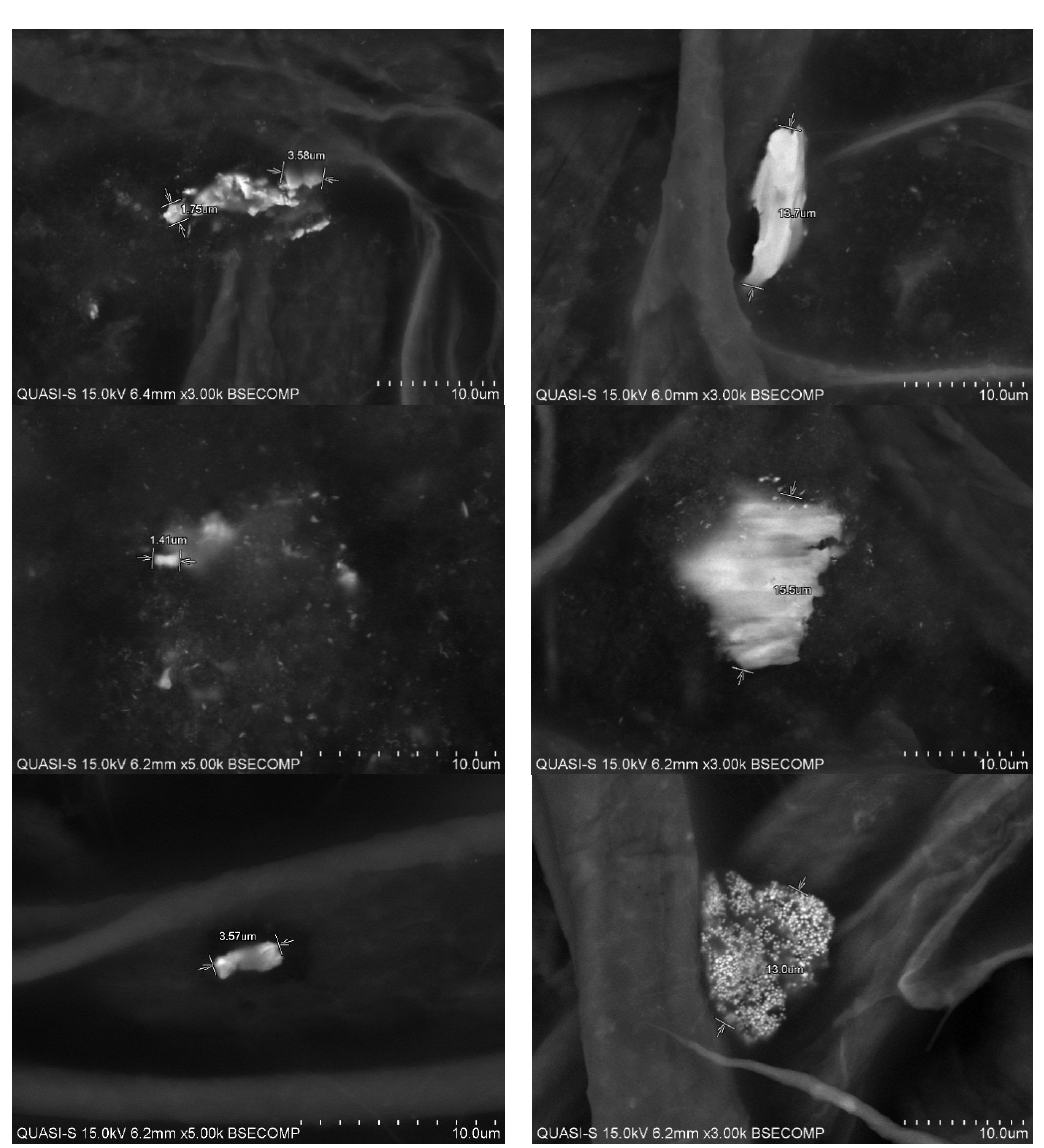
Figure 10. Minimum and maximum particle sizes of filtered wear debris by SEM/EDX microscopy.